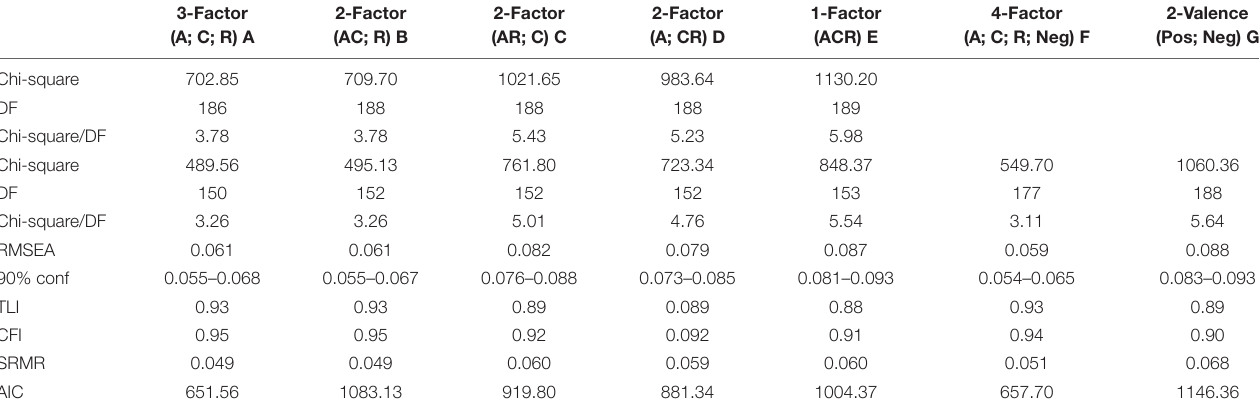
TABLE 2 | Summary of goodness of fit indices for the seven models that converged to a solution (21 items, calibration sample, N = 600). 3-Factor (A; C; R)